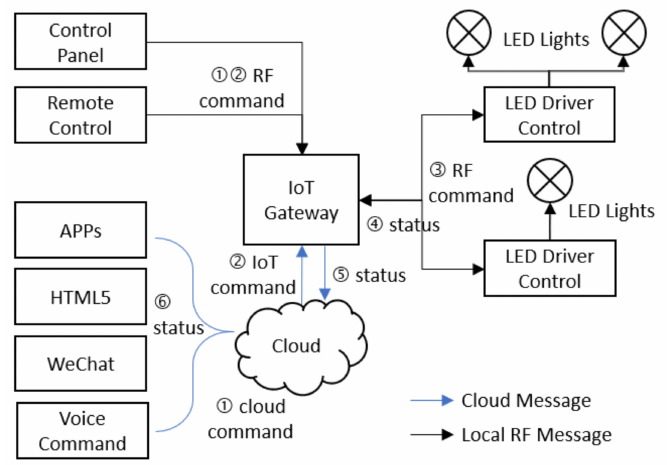
Figure 14. Flowchart of manual switching of lighting